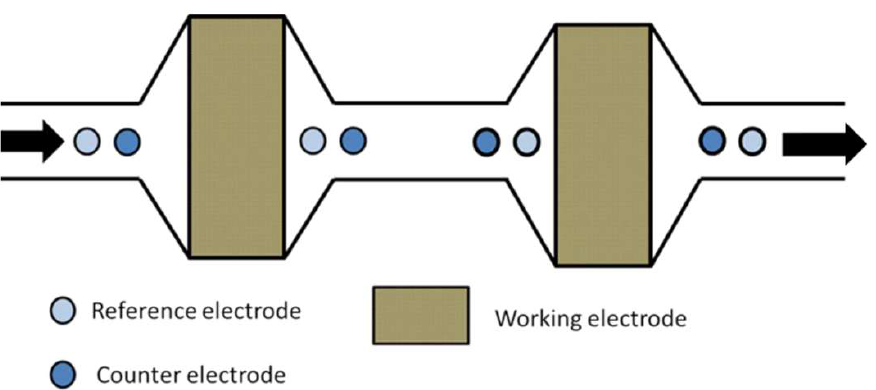
Figure 4. Cross section through a dual coulometric electrode showing the placement of working, counter and palladium-hydrogen reference electrodes (from ref. [24]).